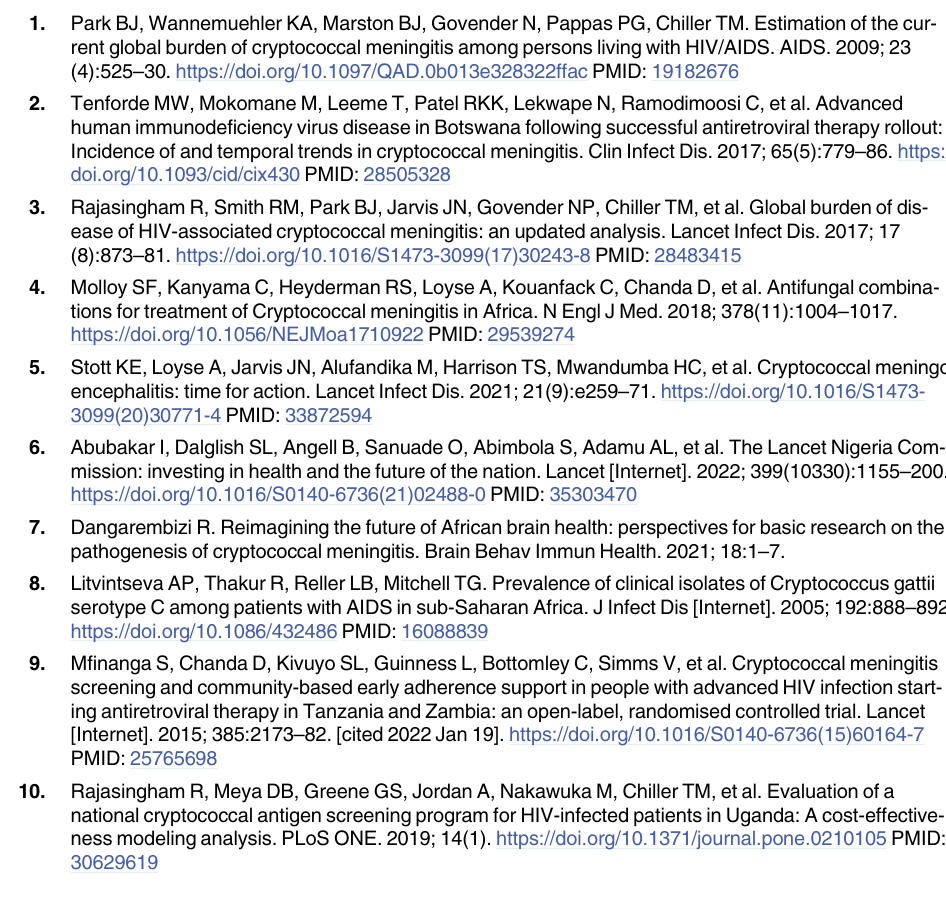
Table B. Burden and fatalities from cryptococcosis before and after the wide coverage of antire- troviral therapy. S2 File. Table A. Population size and health investment characteristics of African